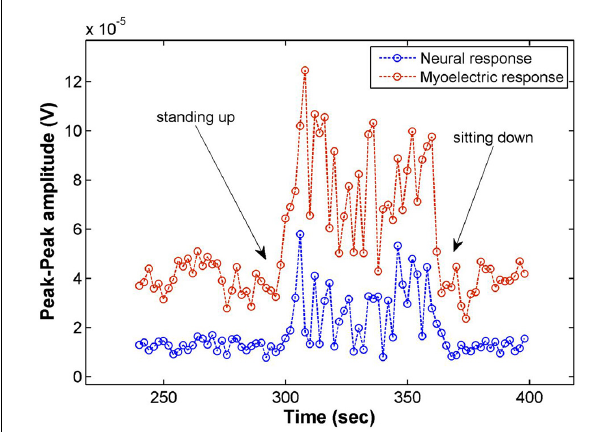
FIGURE 4 | Electrophysiological response amplitudes in Patient 01 recorded on CH4 for stimulation on CH3 (14 Hz, 3.9 mA, 210 µ s pulse width), averaging 28 shots for each data point (2 s). Moving from a sitting to a standing posture increased the amplitude of both the myoelectric response as well as the A β response. The patient reported a slight increase of the stimulation sensation while standing.